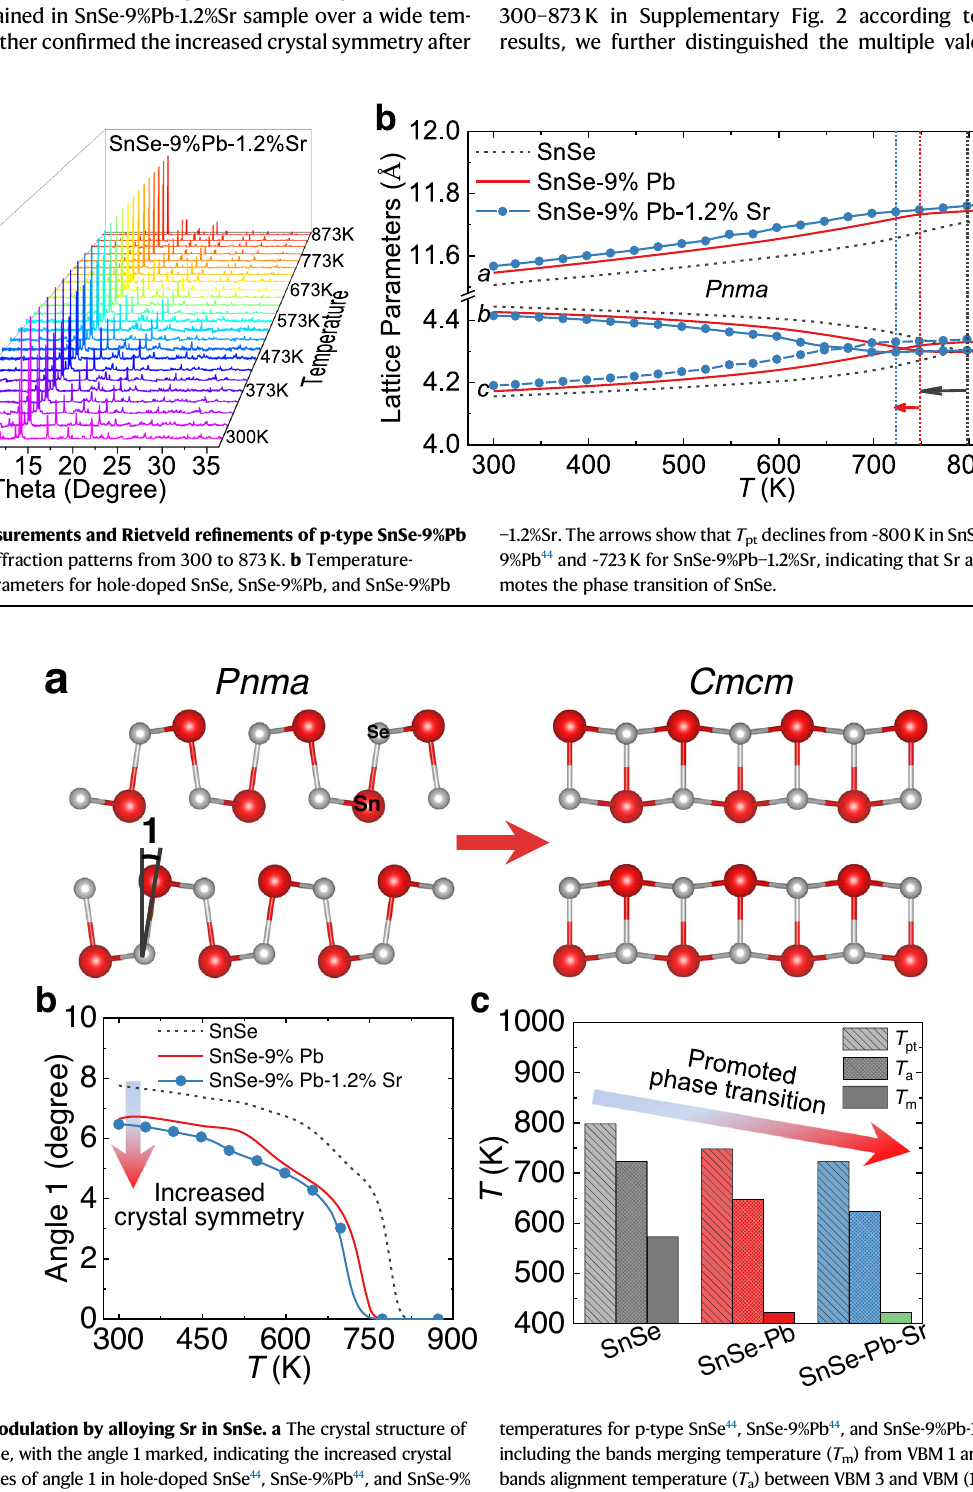
temperatures for p-type SnSe 44 , SnSe-9%Pb 44 , and SnSe-9%Pb-1.2%Sr crystals, including the bands merging temperature ( T m ) from VBM 1 and 2 to VBM (1+2), bands alignment temperature ( T a ) between VBM 3 and VBM (1+2), and completing phase transition temperature ( T pt ).Thereductionof the characteristictemperatures implies that Sr alloying further promotes the multiband synglisis in p-type SnSe.